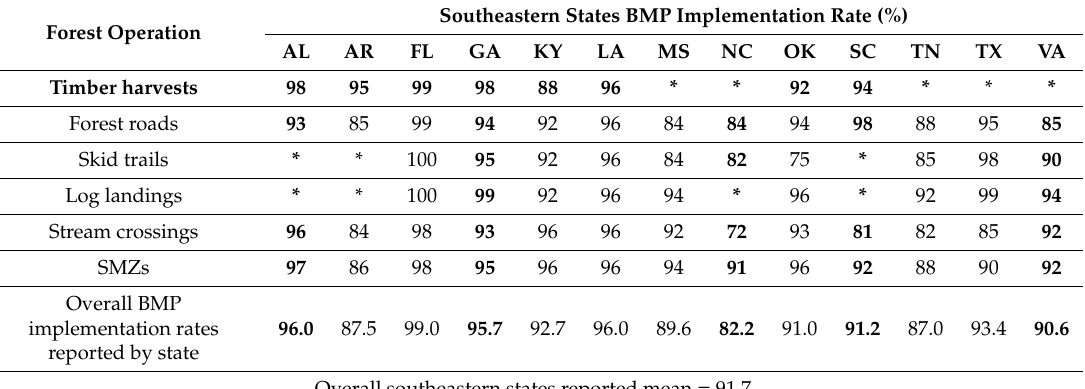
Overall southeastern states reported mean = 91.7 * No data